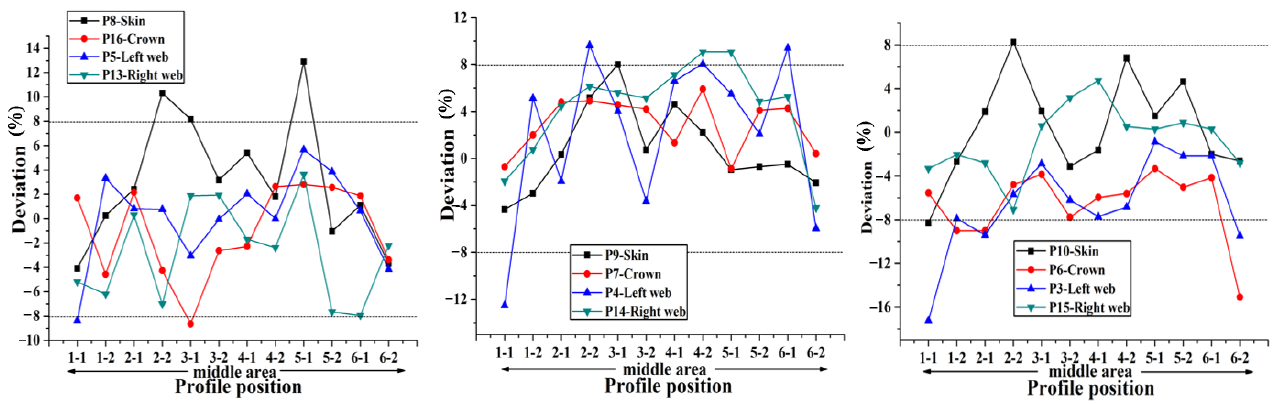
Figure 15. Comparison of dimensional stability of stringer manufactured by 70 HA bladder.